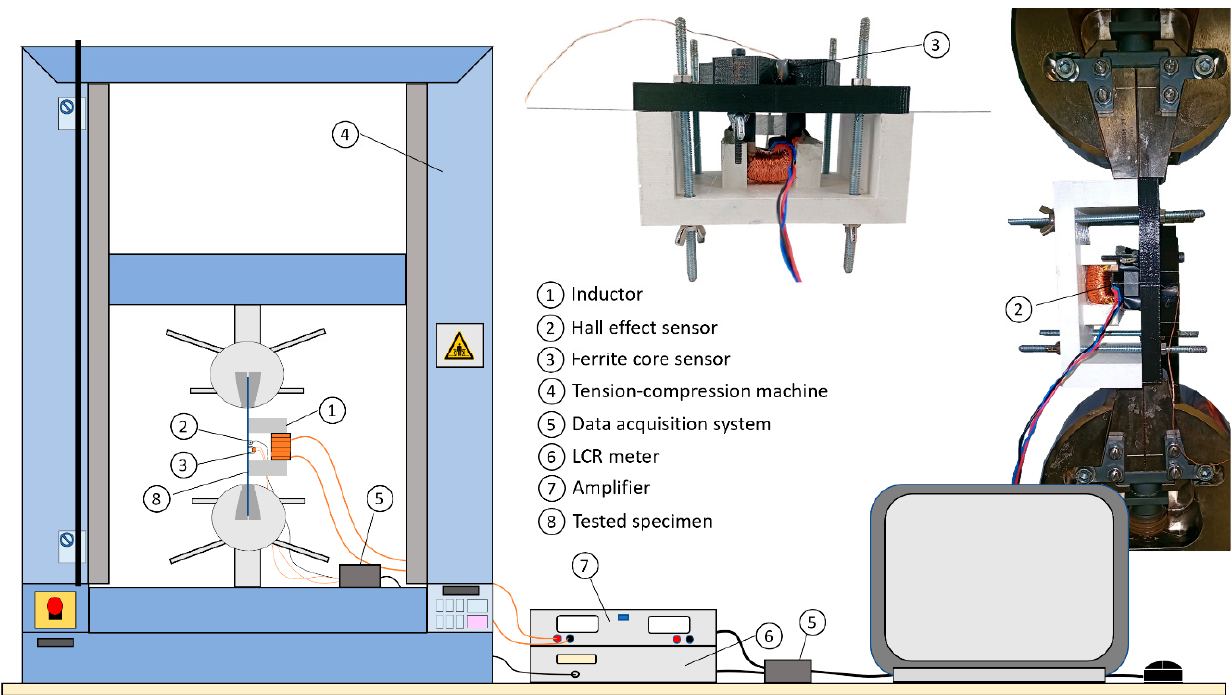
Figure 4. 2D overview of the experimental